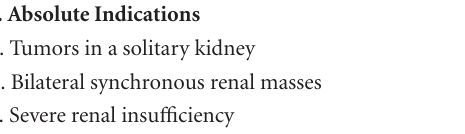
Table 1: Open partial nephrectomy indications (table adapted from